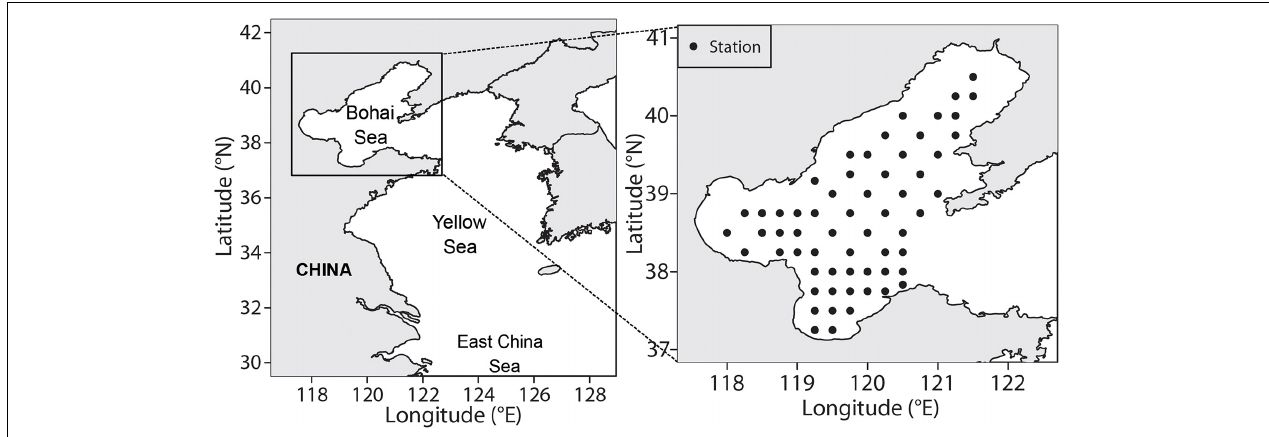
FIGURE 4 | The spatial distribution of the bottom trawl survey stations in the Bohai